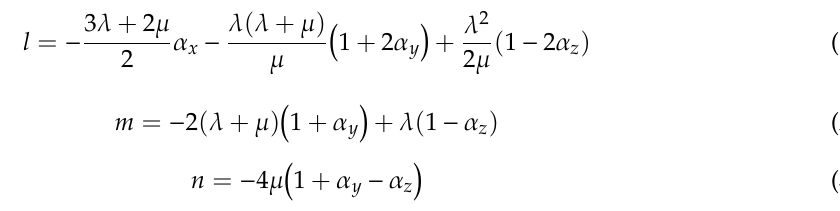
e ff ective longitudinal and shear moduli: M x = V x2 ρ 0 , G y = V y2 ρ 0 , G z = V z2 ρ 0 , plotted as function of stress provided data on the set of second- and third-order elastic moduli of the specimen